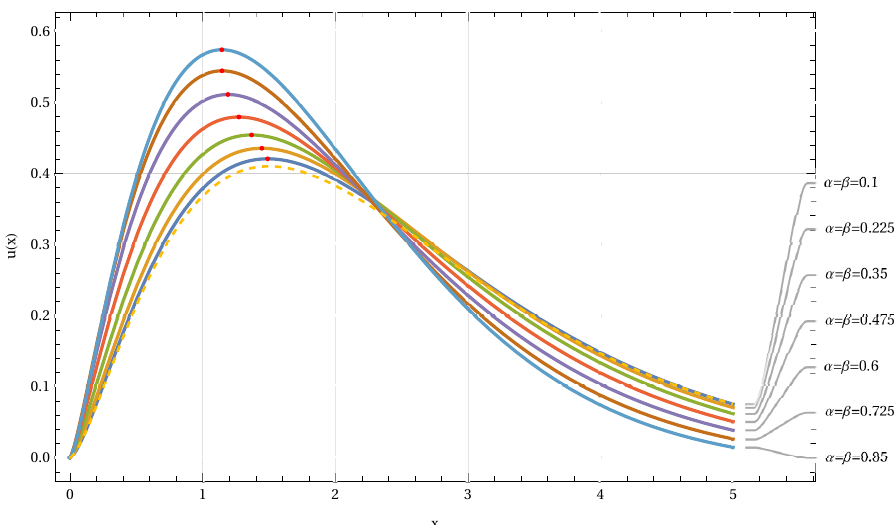
Figure 9. Solutions of Equation (47) represented by (51) for varying α = β (see inset) using an inhomogeneity f ( x ) = x 3/2 exp ( − x ) (dashed line). The parameter value for λ = 1. Number of Sinc points N = 48.